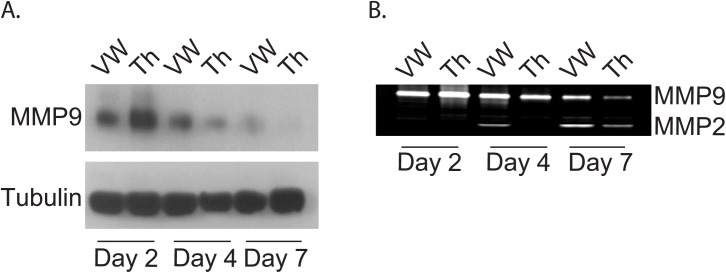
Expression and activity of MMP-9 in the vein walls versus thrombi.Differential expression (A) and activity (B) of MMP-9 in vein wall (VW) versus thrombus (Th) at indicated time points, days 2, 4, and 7. MMP-2 also indicated on zymogram (B) on days 2, 4, and 7. (*,**p<0.05).